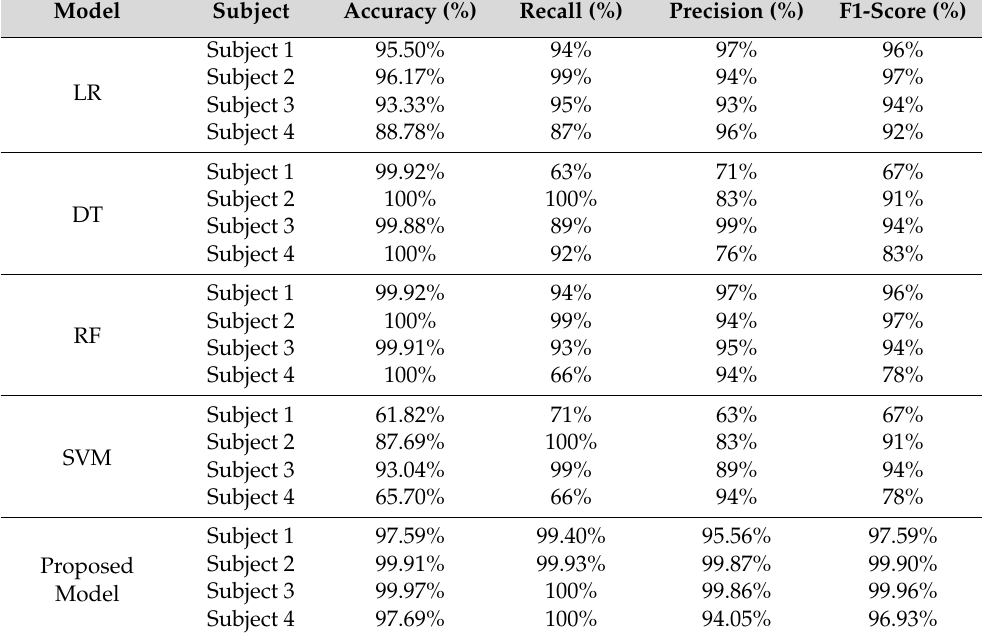
Table 11. Comparison with machine learning